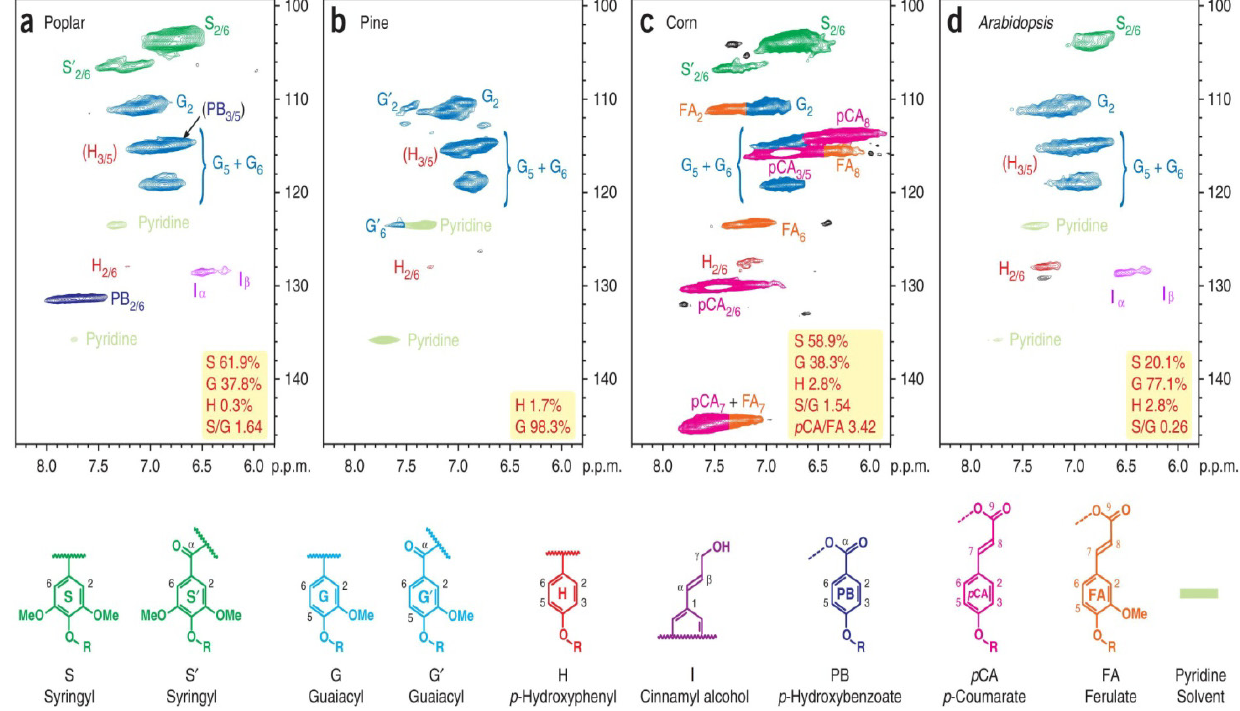
/pyridine- d from 6 5